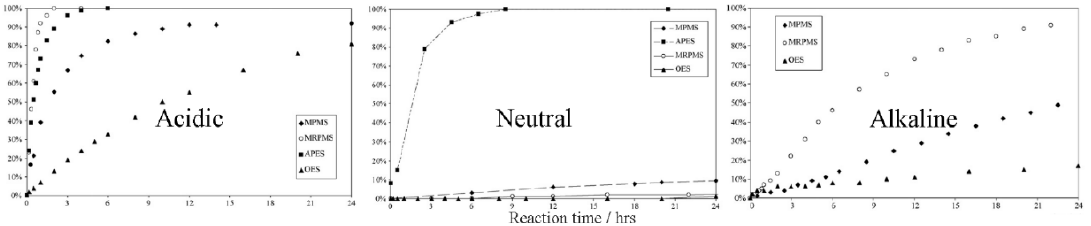
Figure 10. Comparison of hydrolysis rates of MPMS, MRPMS, APES, and OES in different media. Reprinted with permission from [65]. Copyright Elsevier, 2008.